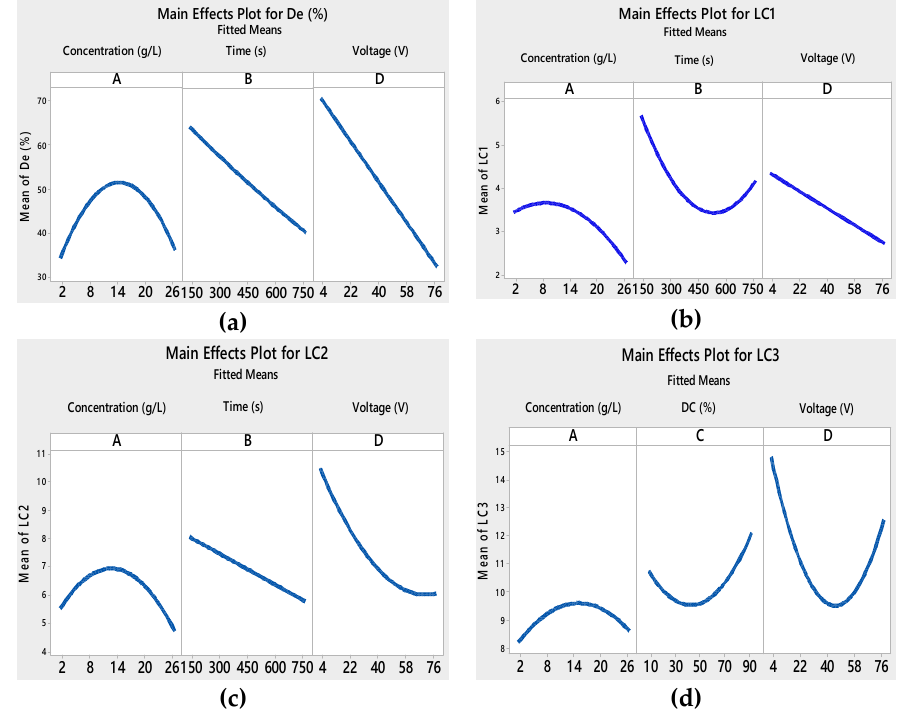
Figure 3. Main effects plots for different responses: ( a ) degradation, ( b ) L C1 , ( c ) L C2 , and ( d ) L C3 . Figure 3. Main e ff ects plots for di ff erent responses: ( a ) degradation, ( b ) L